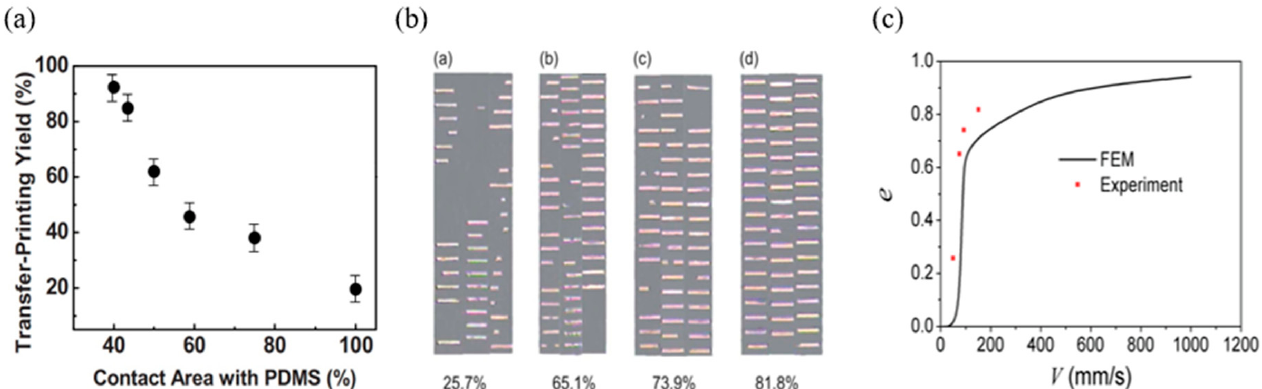
Figure 4. Kinetic control transfer printing principle. ( a ) The relationship between the percentage of the seal contact area and the percentage of the successful transfer printing area (reproduced from [71]), ( b ) optical image of transferred Si tape under different peeling speeds of the PDMS seal (reproduced from [37]), and ( c ) graph of transfer printing efficiency and peeling speed (reproduced from [37]).